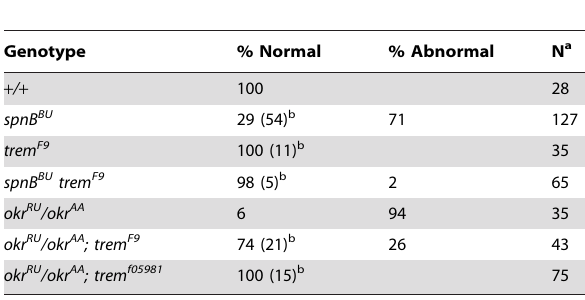
Table 9. Rescue of karyosome defect by trem of the DNA repair mutants spnB and okr